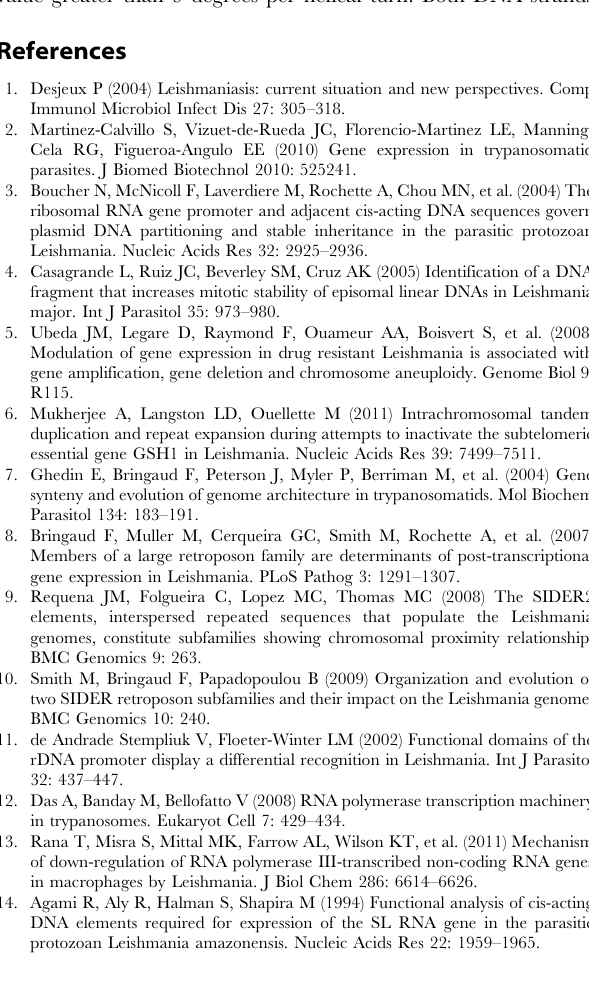
are depicted in grey below bar plots, overlaid with CDS features shown in blue. Features labeled as ncRNA, snRNA or snoRNAs are shown in green. tRNAs are shown in red. rRNAs are shown in brown. (PDF) Figure S6 Graphical representation of IC for regions with high RIIC-score for all L. major chromosomes. The graphs are the same as figure 1. IC for regions with high RIIC score are indicated at the top. Sites associated with acetylated H3 histone [18] are indicated as small vertical lines. (PDF) Figure S7 Location conservation of high RIIC scoring regions in L. major and L. infantum chromosomes. The graphs are the same as figure 1. Blast HSPs longer than 100 bp and with at least 80% similarity are displayed in red scale and blue lines represent inversions. (PDF) Table S1 Genome intrinsic curvature in Tritryps. (PDF) Table S2 Chromosome intrinsic curvature in L. major.